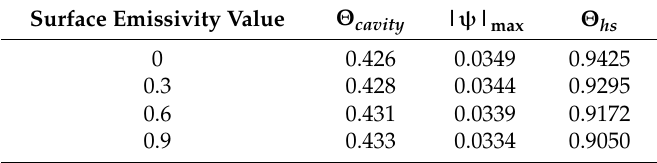
Table 4. Variations of different considered parameters for Ra = 10 8 , τ =